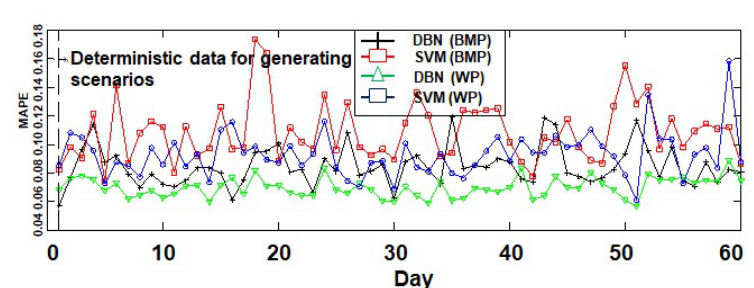
Figure 4. The MAPE statistics of WP and BMP.